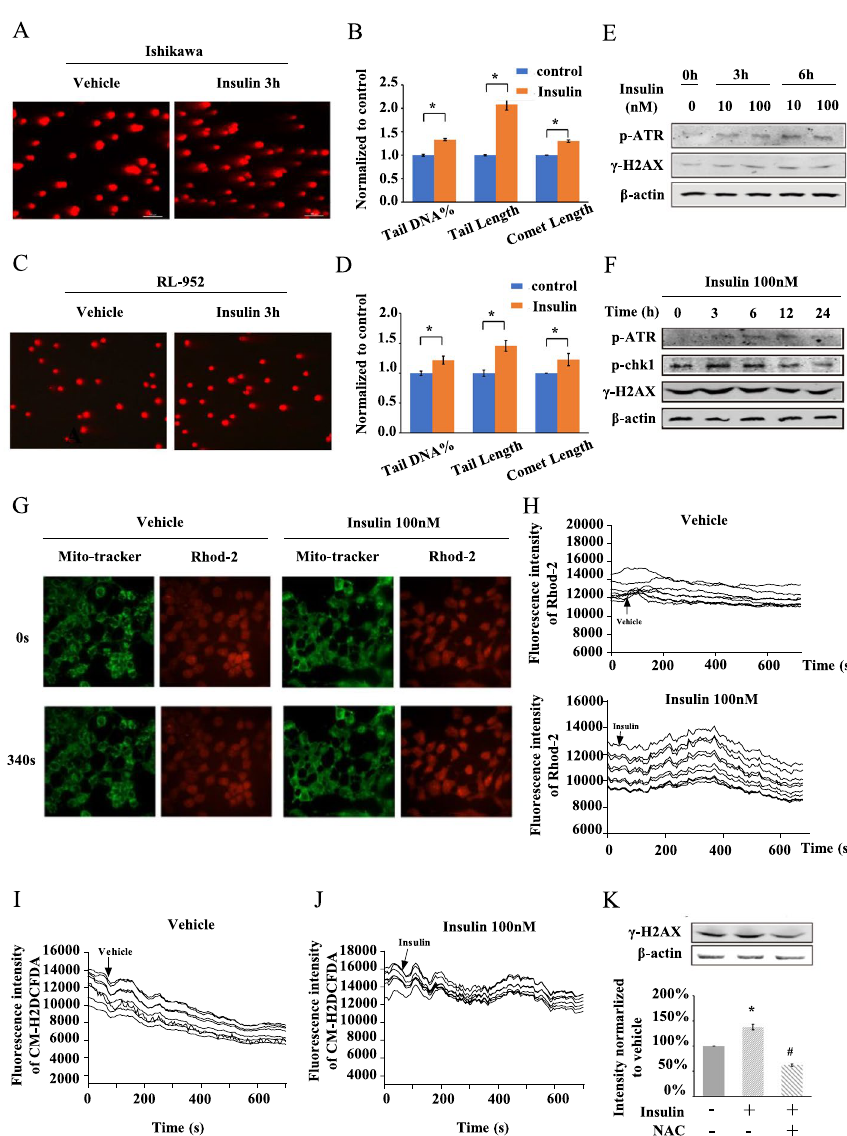
Fig. 2 Insulin induces DNA damage, ROS and Ca 2 + homoeostasis imbalance. A , C Comet images assessing DNA damage in Ishikawa cells and RL-952 cells after treatment with insulin (100 nM) for 3 h. B , D Statistical analysis of tail DNA, tail length and comet length by comet assay software. n 100. E Immunoblot of DNA = damage repaired response kinase p-ATR and DNA damage marker γ-H2AX in Ishikawa cells after insulin (10, 100 nM) treatment for 0, 3 and 6 h. F Immunoblot of p-ATR, p-Chk1 and γ-H2AX in Ishikawa cells after insulin (100 nM) treatment for 0, 3, 6, 12 and 24 h. G Confocal microscopy detecting transient changes of mitochondrial Ca 2 + after insulin (100 nM) stimulation. (200 ) Ishikawa cells are loaded with mitochondrial × probe Mito-tracker and mitochondrial Ca 2 + probe Rhod-2, then stimulated by vehicle or insulin. H Fluorescence intensity indicating mitochondrial Ca 2 + concentration change within 600 s treatment. Each curve indicates the change in a single isolated cell. I , J ROS analysis in Ishikawa cells after stimulation by vehicle or insulin (100 nM). CM-H2DCFDA is ROS indicator. K Immunoblot of γ-H2A in Ishikawa cells after insulin and/or NAC treatment. Histogram plot shows γ-H2A expression level relative to β-actin. * P < 0.05, insulin treatment alone compared with vehicle. # P < 0.05, NAC insulin combination treatment compared + with insulin treatment